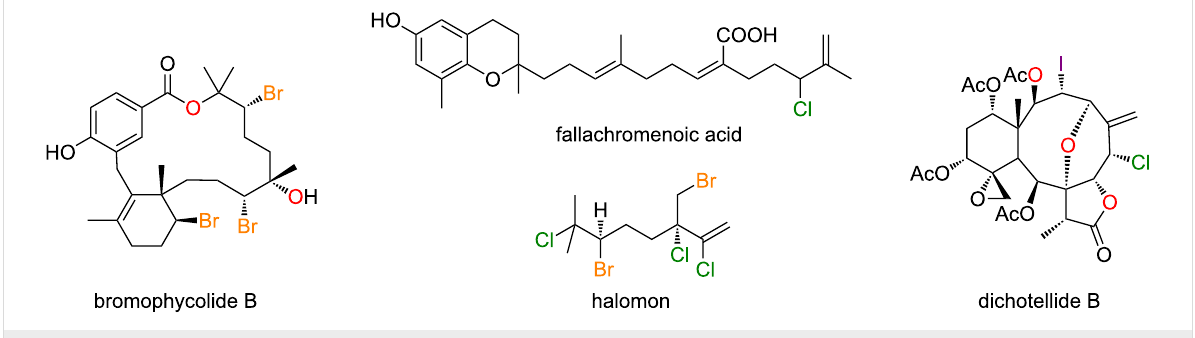
Figure 1: Halogenated terpenoids from natural sources.